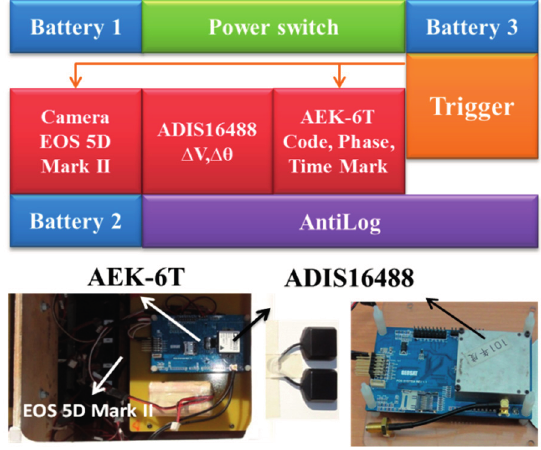
Figure 6. The proposed UAV platform.